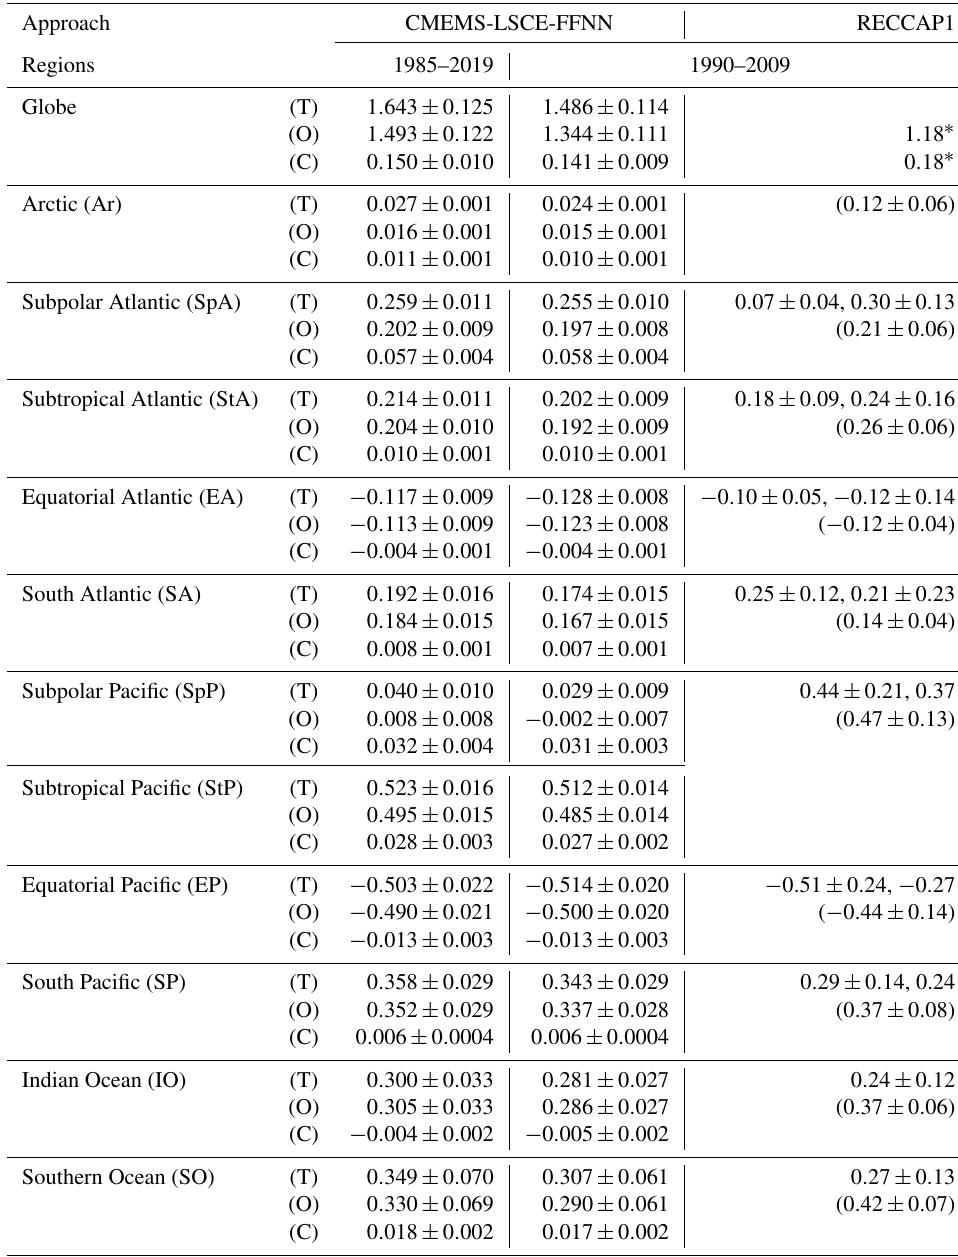
Table 2. Yearly mean of contemporary air–sea CO 2 fluxes (PgCyr − 1 ) integrated over the global ocean and 11 RECCAP1 regions. The mean estimate and uncertainty ( µ ensemble ± σ ensemble ) of the CMEMS-LSCE-FFNN approach is shown for the coast (C), the open ocean (O), and the total area (T). For a comparison, estimates derived from RECCAP1 (Canadell et al., 2011; Schuster et al., 2013; Ishii et al., 2014; Sarma et al., 2013; Lenton et al., 2013; Wanninkhof et al., 2013) are provided. In column “RECCAP1”, values in parentheses are the “best” estimates proposed by RECCAP1 studies which were derived from averages or medians of estimates based on the p CO 2 climatology or p CO 2 diagnostic model and/or the atmospheric and ocean inversions and GOBMs. The RECCAP1 values outside of parentheses are the estimates derived from different methods mapping observation-based data of p CO 2 . With an exception for the global estimate (denoted by ∗ ) (Wanninkhof et al., 2013), those of the RECCAP1 sub-basins are available only for the open